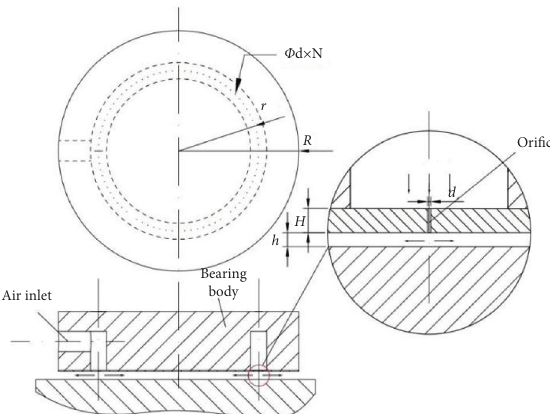
Figure 1: Physical model of annular array microporous.